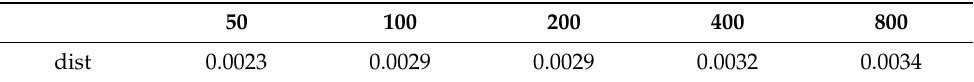
Table 1. Procrustes distances computed between the mean surfaces of ape crania generated by sliding TPS and TPS&NICP after re-semilandmarking and re-warping the template mesh. 50 100 200 400 800 dist 0.0018 0.0025 0.0024 0.0030 Table 2. Procrustes distances computed between the mean landmarks and semilandmarks of ape crania generated by sliding TPS and TPS&NICP after re-semilandmarking the warped mesh. 50 100 200 400 800 dist 0.0023 0.0029 0.0034